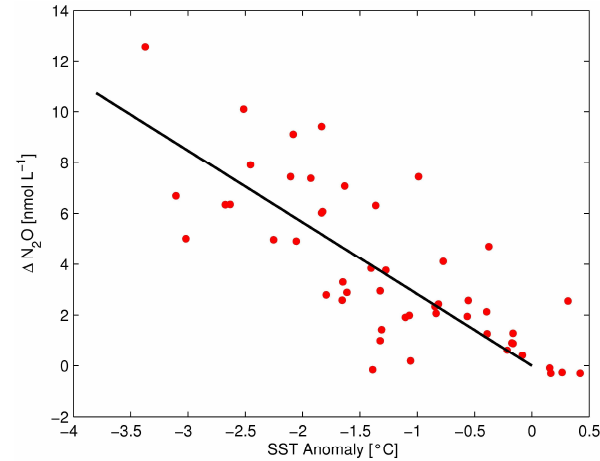
Fig. 3. Diapycnal N 2 O (red dots, right axis) and sea-to-air fluxes (black dots, right axis) projected to 18 ◦ N and bottom depth along 18 ◦ N (solid line, left axis). Fluxes from stations to the north and south of 18 ◦ N were projected onto 18 ◦ N according to their dis- tance from the 400m isobath.